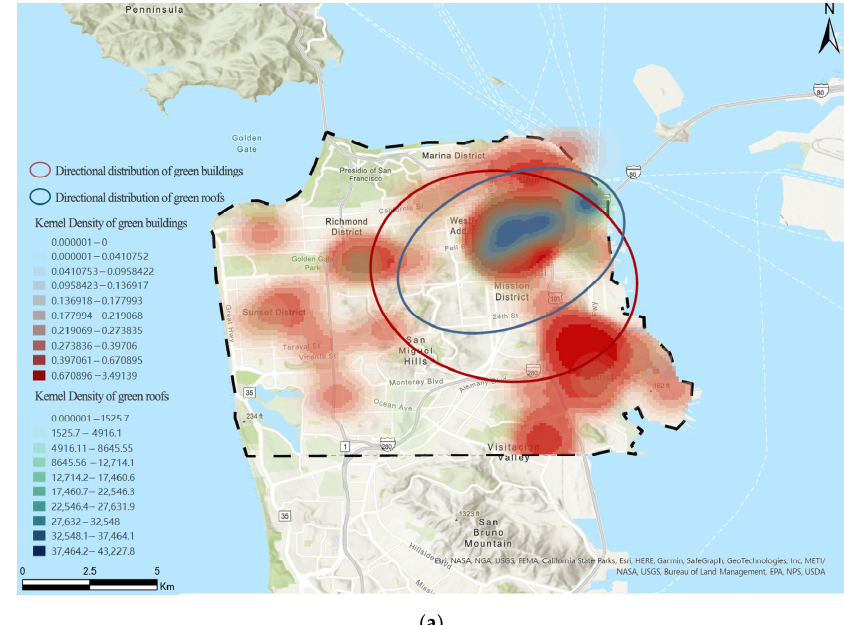
Figure 5. Comparison of the number of green roofs and green buildings in different regions.